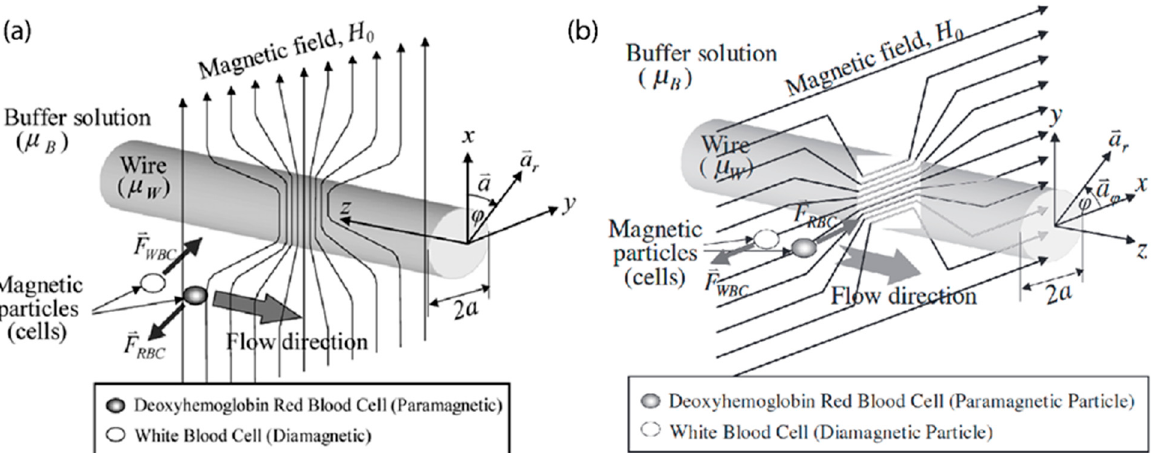
Figure 2. Operational modes for the microfluidic sorter. ( a ) Diamagnetic mode. Copyright 2005 IEEE. Reproduced with permission from [46]. ( b ) Paramagnetic mode for operation. Reproduced with permission [48]. Copyright 2006 IET.